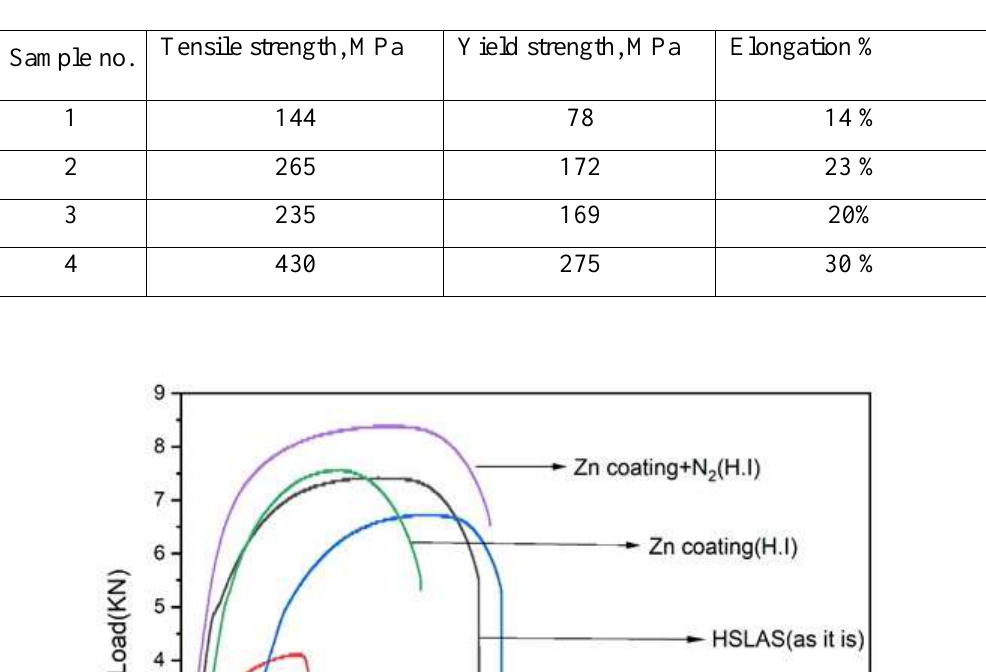
Table 2 : Tensile test results for HSLAS with different surfaces treatments.